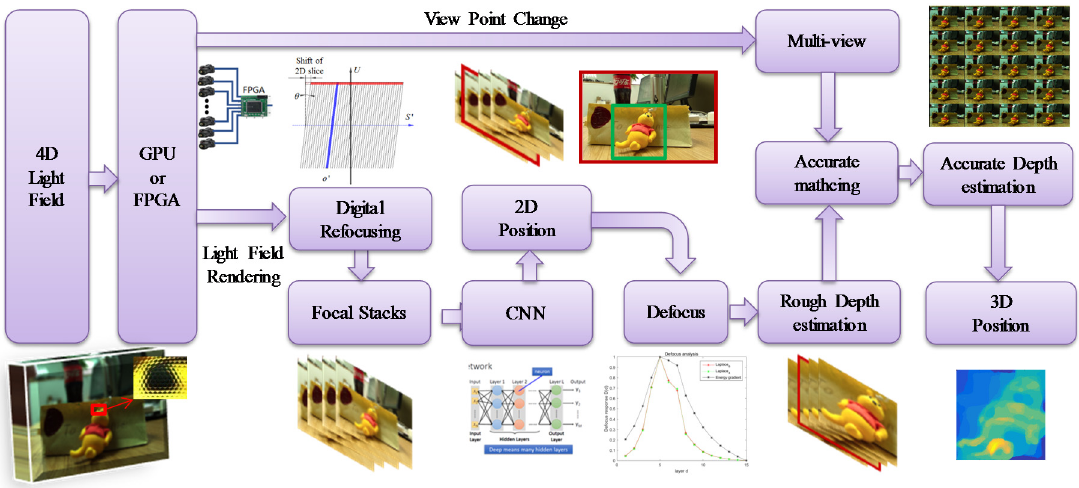
Figure 1. Framework of the proposed method.